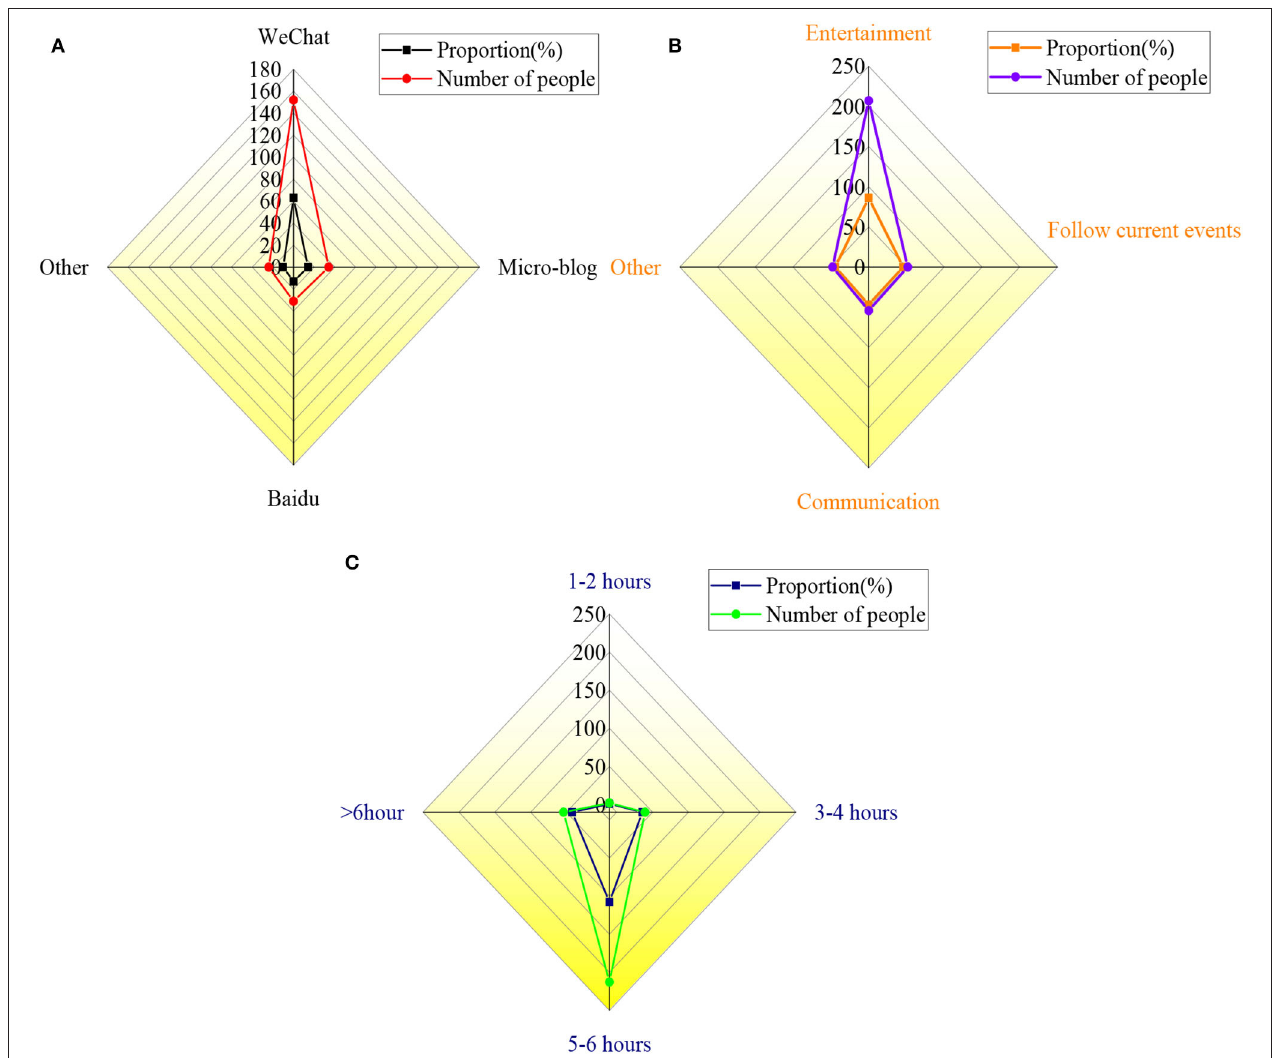
FIGURE 13 | Analysis of specific results of using new media for college students (A) shows the types of new media used by college students; (B) means the purpose of college students using new media; (C) is the time of college students using new